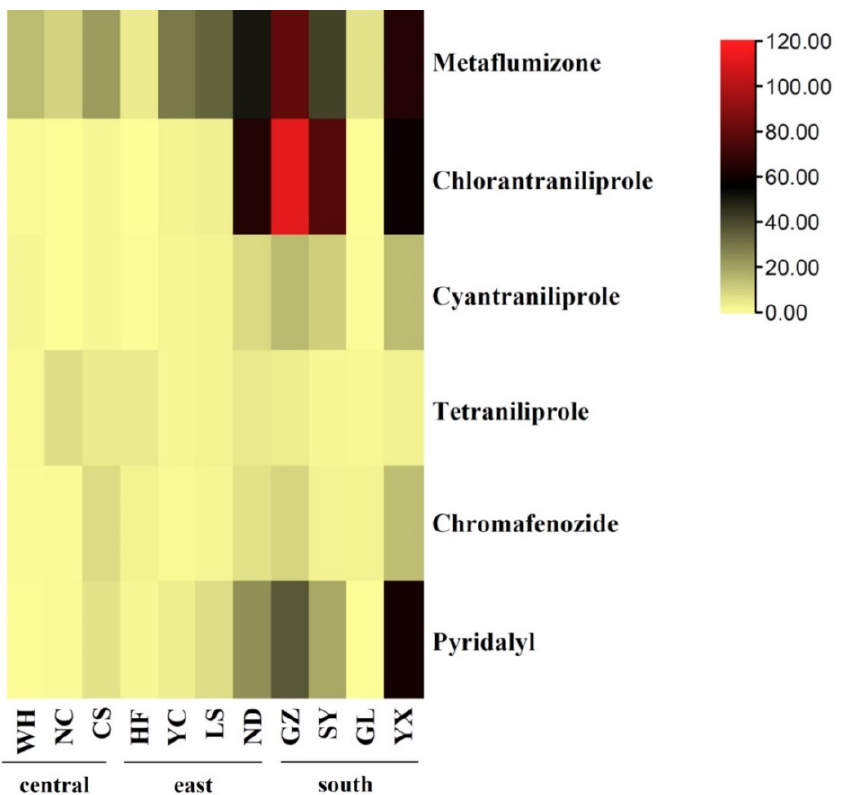
Figure 2. Comparative heatmaps of resistance ratios (RR) against six insecticides in eleven field- collected populations of S. litura from different regions of China, including central China, east China and south China. Table 4. Insecticide susceptibility of S. litura collected from central China.